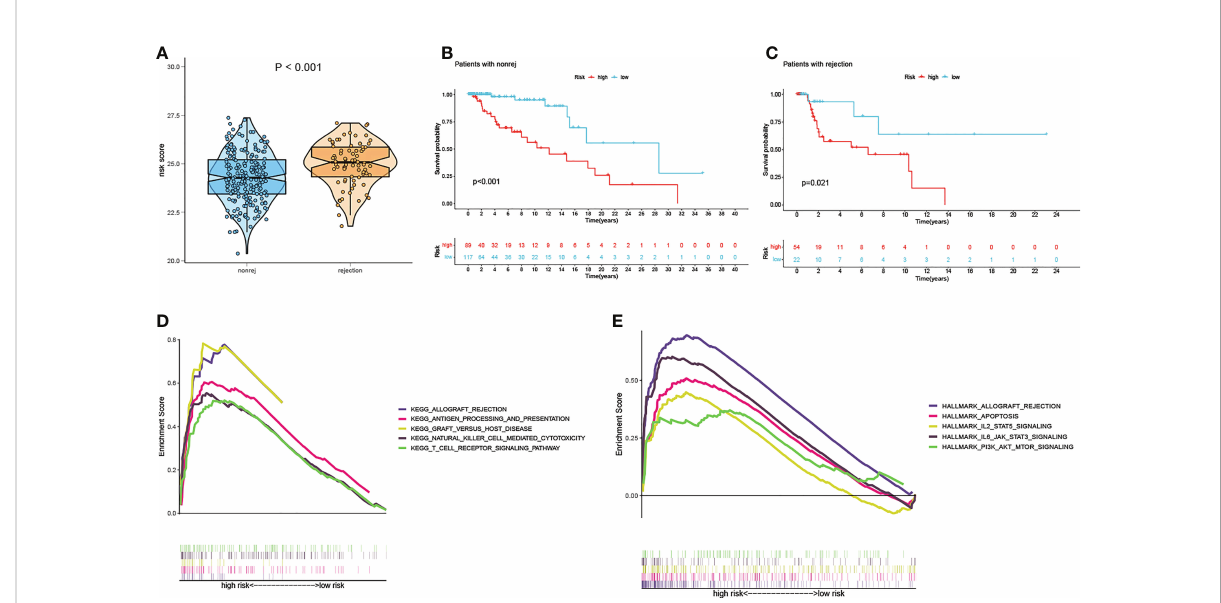
FIGURE 3 Test of suitability of the prognostic prediction model. (A) Violin plot of risk score in non-rejection and rejection group. (B) The K-M curve showed that the high-risk group had a more inferior graft survival than the low-risk group in non-rejection and (C) rejection group. (D) Gene enrichment analysis of KEGG pathway and (E) hallmark pathway in high-group versus low-group. K-M, Kaplan –